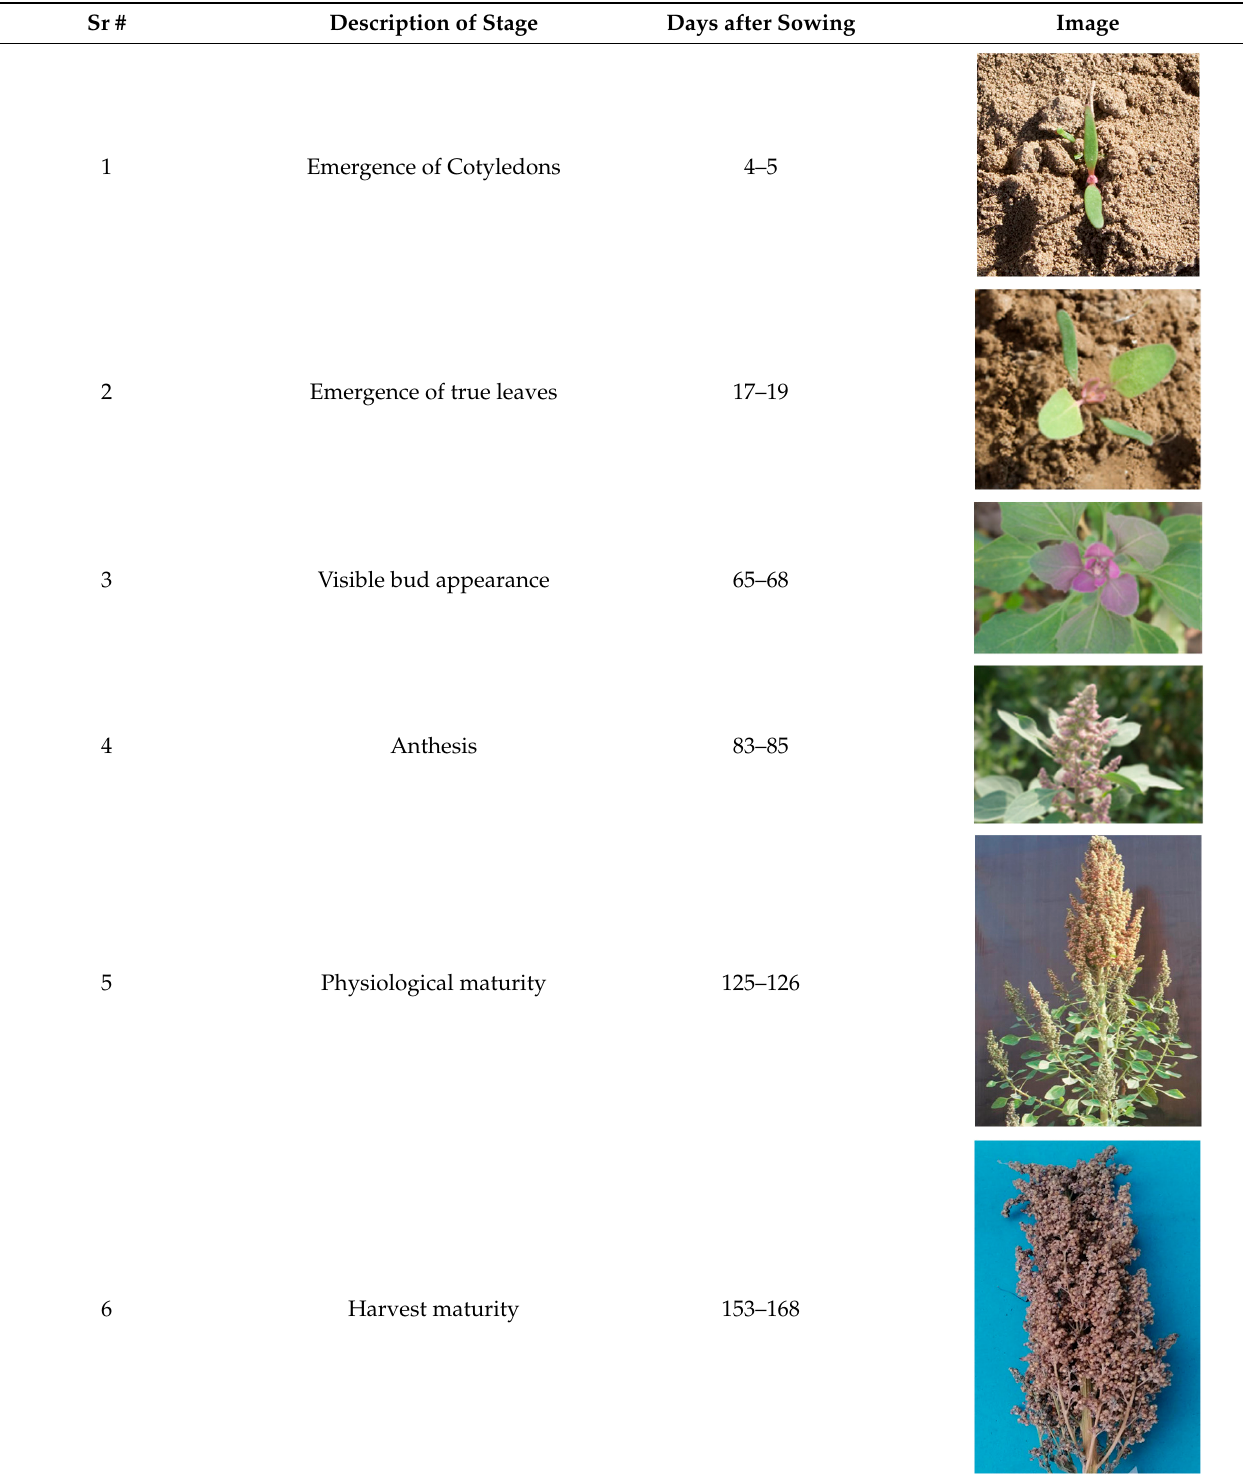
Table 1. Description of phenological stages of quinoa accession under agro-climatic conditions of